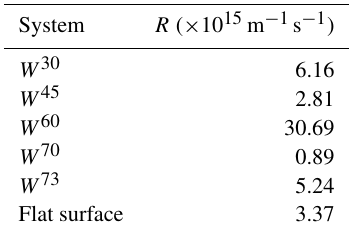
Table 1. Ice nucleation rate R on different wedge systems using the TIP4P/Ice